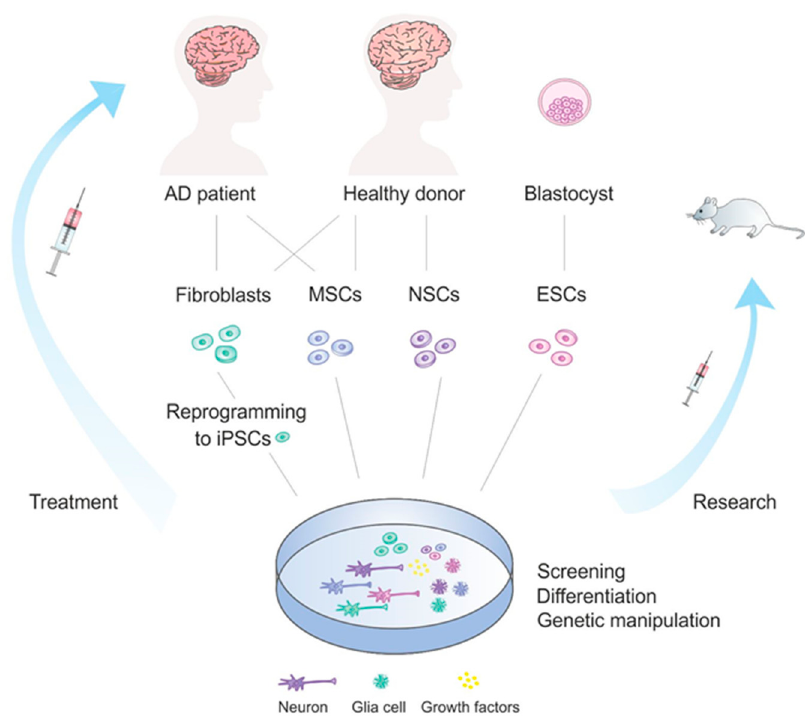
Figure 1. Stem cell treatment development in Alzheimer’s disease. AD patients or healthy donors, or a blastocyst in case of ESCs, can be the source of different stem cell types which can be used for treatment development. Stem cells can be further involved in various processes, such as differentiation, genetic manipulation, used for drug screening or tested on mice and other organisms. Finally, stem cells reach the AD patients and are applied in therapeutic purposes.